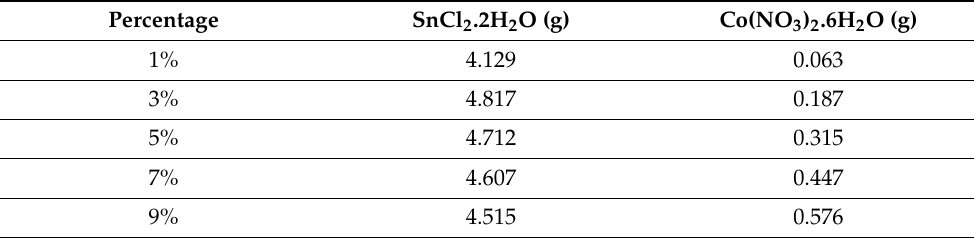
Table 1. Composition of Co-SnO 2